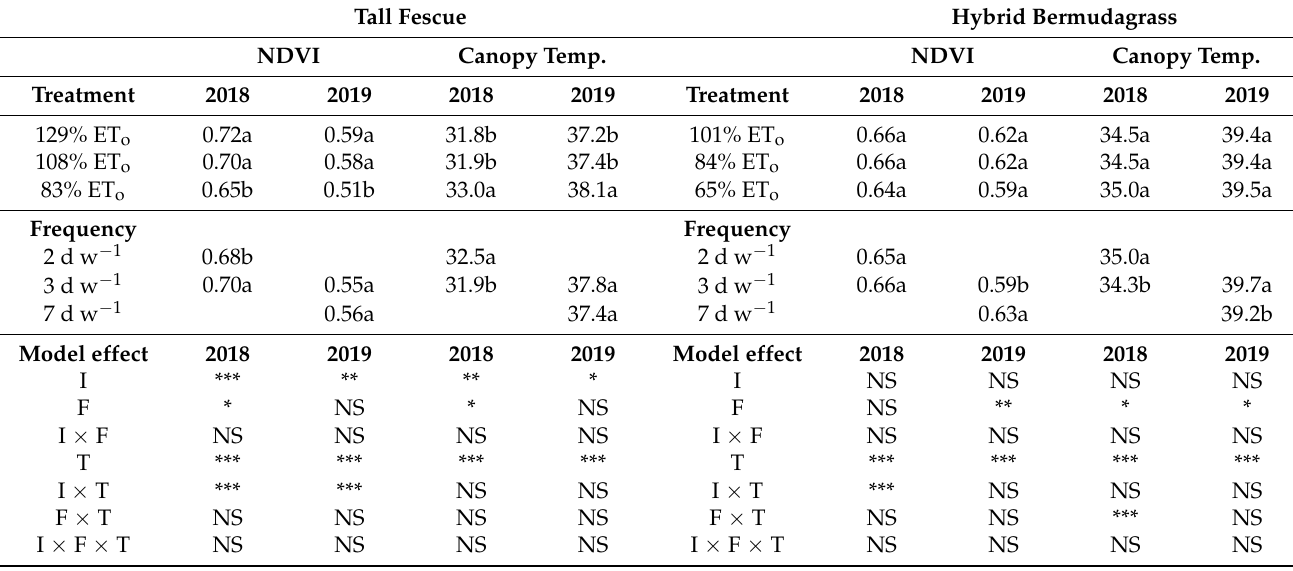
I × T *** *** NS NS I × T NS